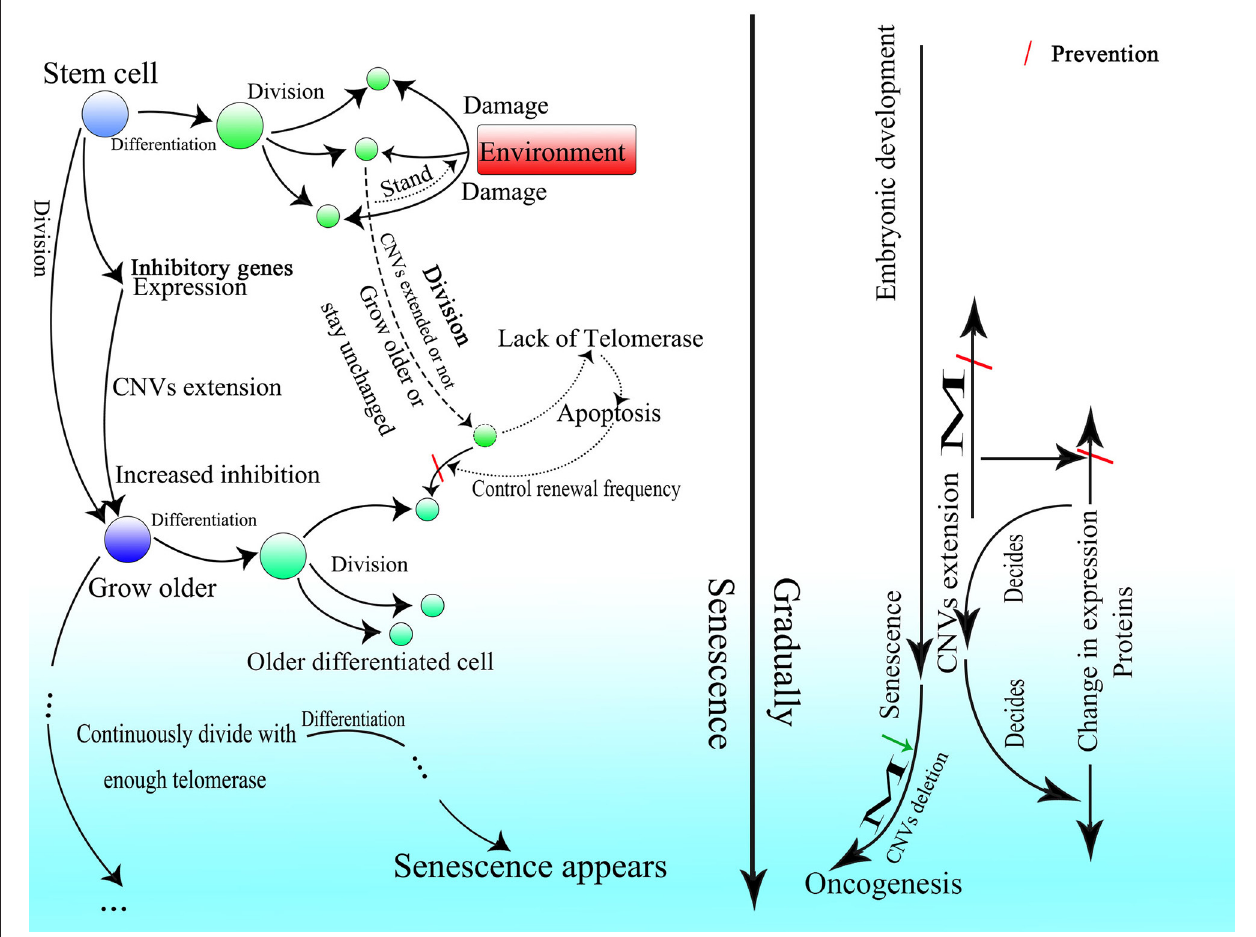
FIGURE 9 | A proposed mechanism of senescence under the CNV extension mechanism. The entirely differentiated cell could be differentiated from the stem cell, perform certain functions, and protect the stem cell lying inside. The CNVs of inhibitory genes would be extended as the cell divides and gradually lead to senescence in the stem cell. The stem cell could continuously divide with sufficient telomerase activity and ultimately lead to senescence as the cell divides. Because of a lack of telomerase, the somatic cells would be forced to apoptosis and then substituted by older cells differentiated from stem cells. Moreover, methylation would have critical effects in terms of stabilizing the genome from embryogenesis to